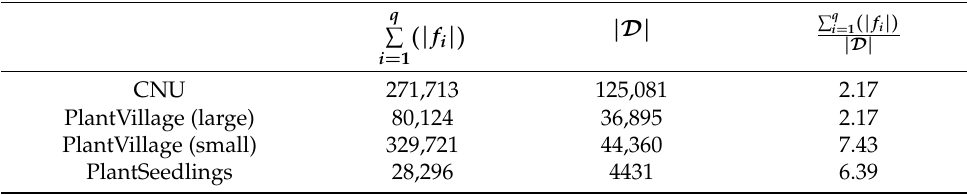
Table 2. Total number of samples in the folds and training